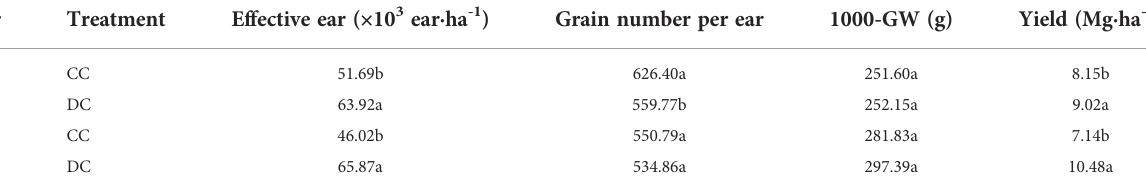
TABLE 1 Grain yield and grain yield components of CC and